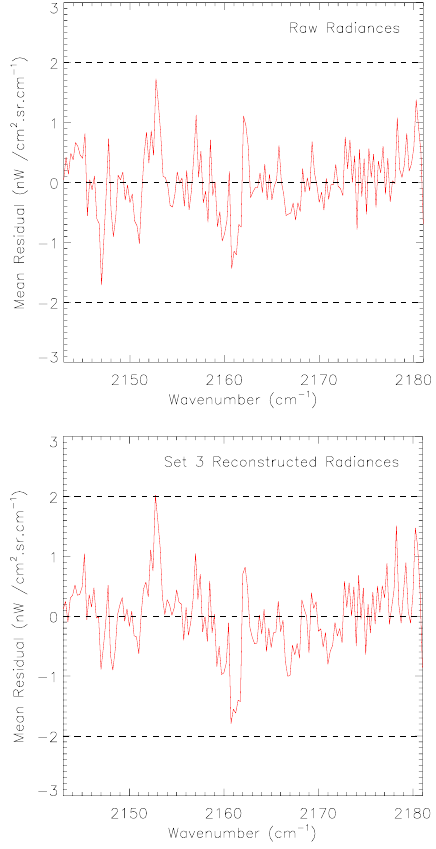
Fig. 12. Mean residual fit to IASI observations from all footprints in Fig. 10 for the raw radiances (left) for the set 3 reconstructed radiances (right). The dashed lines show the instrument noise